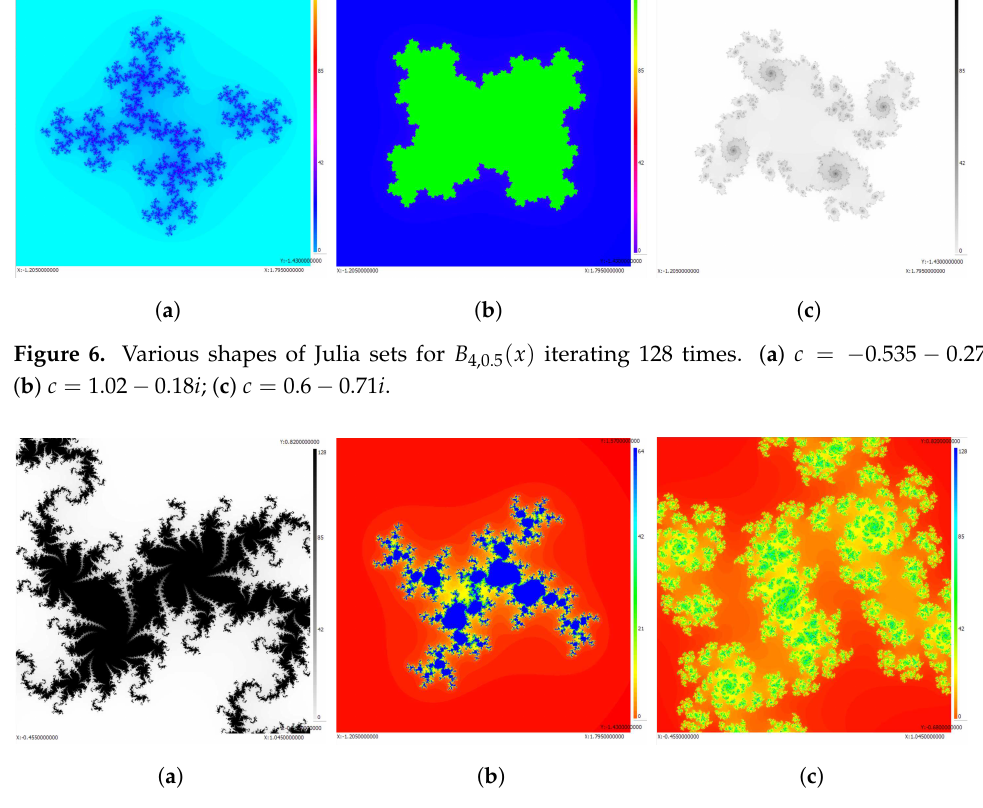
Figure 7. Various shapes of Julia sets for B 4,0.5 ( x ) iterating 128 or 68 times. ( a ) c = 0.965 − 0.665 i ; ( b ) c = 0.65 + 0.835 i ; ( c ) c = − 0.30 + 0.395 i